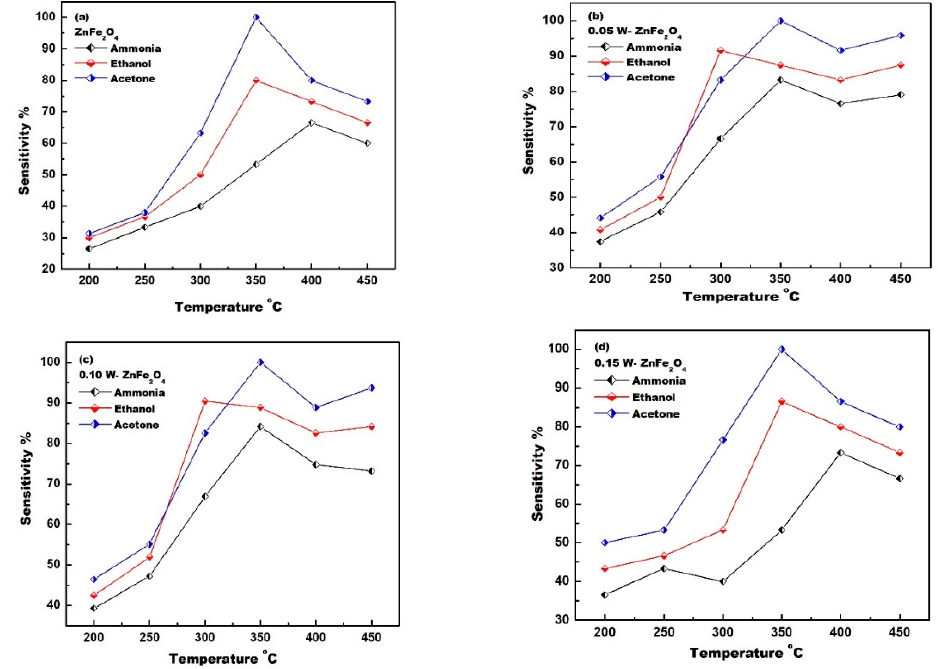
Figure 9. Ferrite sensor sensitivity to ammonia, ethanol, and acetone at different temperatures (gas concentration of 2000 ppm); ( a ) ZnFe 2 O 4 , ( b ) ZnW 0.05 Fe 1.95 O 4 , ( c ) ZnW 0.1 Fe 1.90 O 4 , and ( d ) ZnW 0.15 Fe 1.85 O 4 .